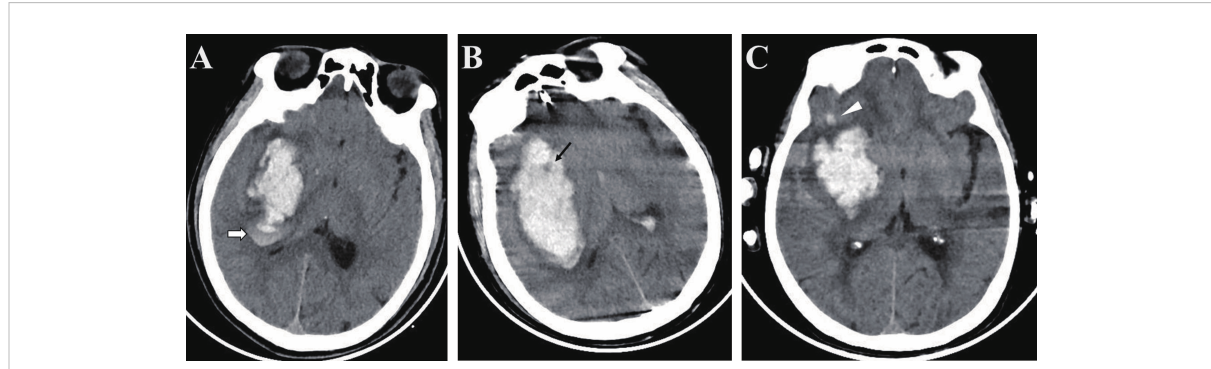
FIGURE 6 Examples of biomarkers on non-enhanced computed tomography (A) The blend sign is de fi ned as an area with relatively low attenuation adjacent to an area with high attenuation (white arrow); (B) The black hole sign represents a low-density area within a hematoma with high density (black arrow); (C) The satellite sign represents a small lesion completely separate from the main hemorrhage visible in at least one slice (white